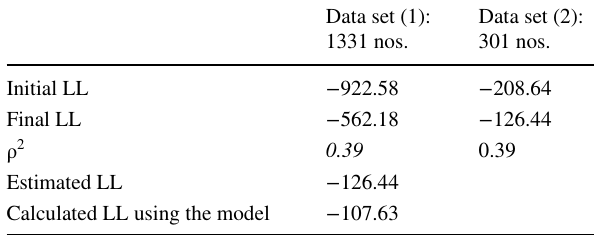
Table 7 Model validation